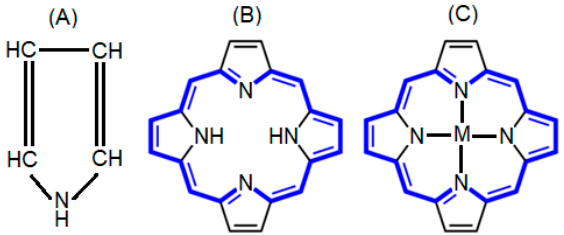
Figure 1. Typical structures, i.e., ( A ) pyrrole, and ( B ) porphyrin consist of four pyrrole rings joined